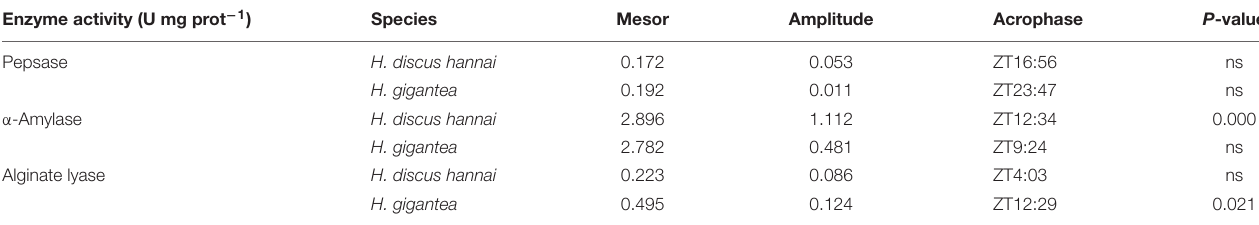
TABLE 3 | Cosinor analysis results obtained based on the digestive enzyme activity levels. Enzyme activity (U mg prot − 1